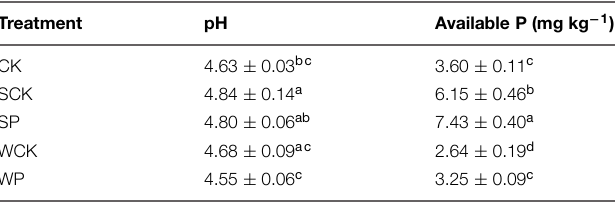
TABLE 3 | Soil pH and available P concentration after phytoremediation for 120